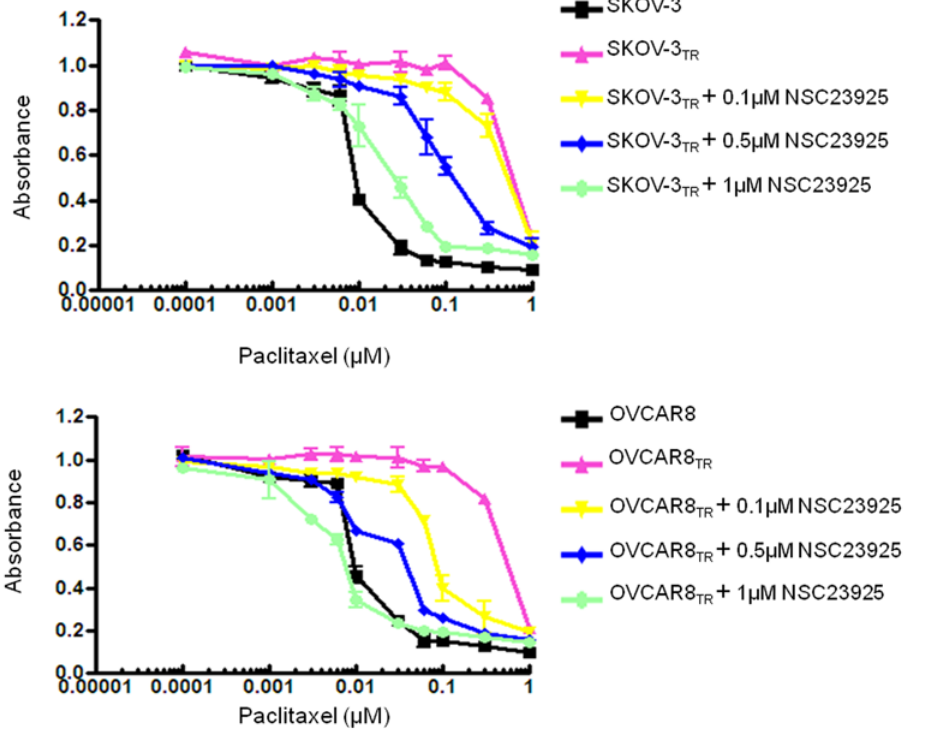
Figure 3. Effect of NSC23925 to reverse drug resistance in MDR cell lines. Cells were treated with the paclitaxel and NSC23925 in RPMI1640 complete media at the indicated concentrations. The relative sensitivity of each line to paclitaxe was determined by MTT analysis 6 days posttreatment. A : Reversal of paclitaxel resistance by NSC23925 in SKOV-3 TR cells. B : Reversal of paclitaxel resistance by NSC23925 in OVCAR8 TR cells.